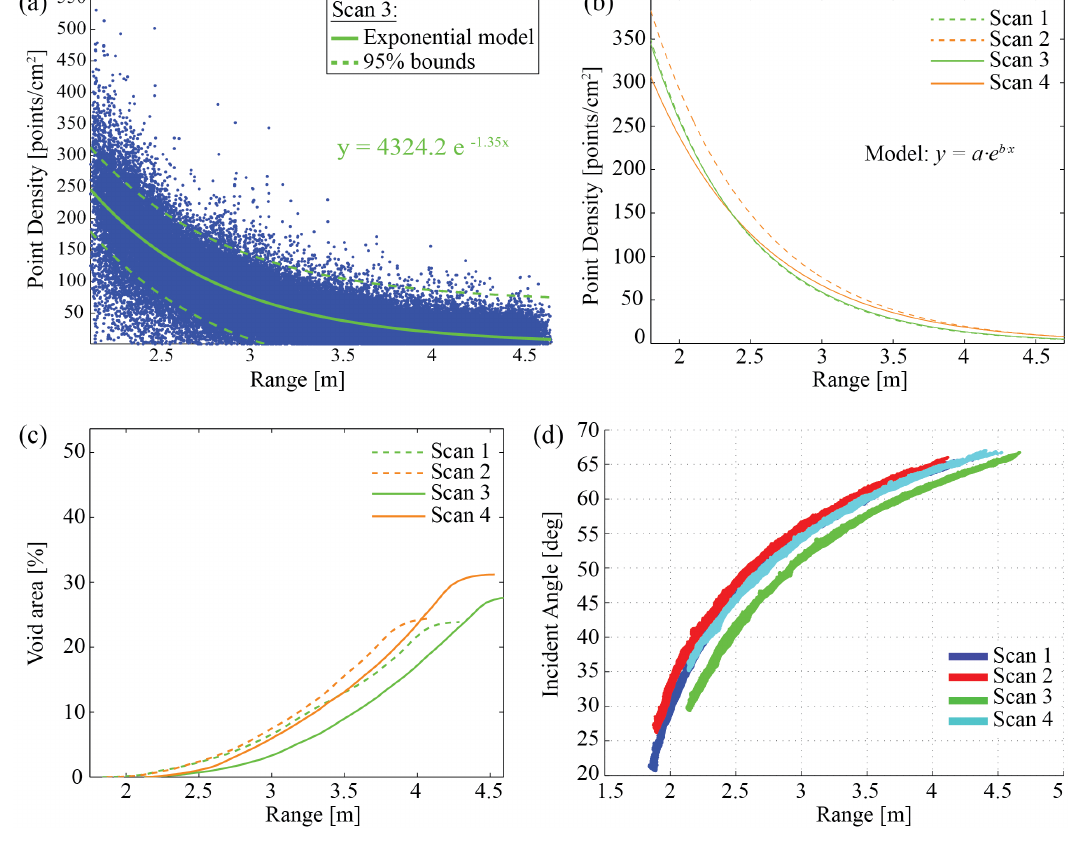
The red regions marked by